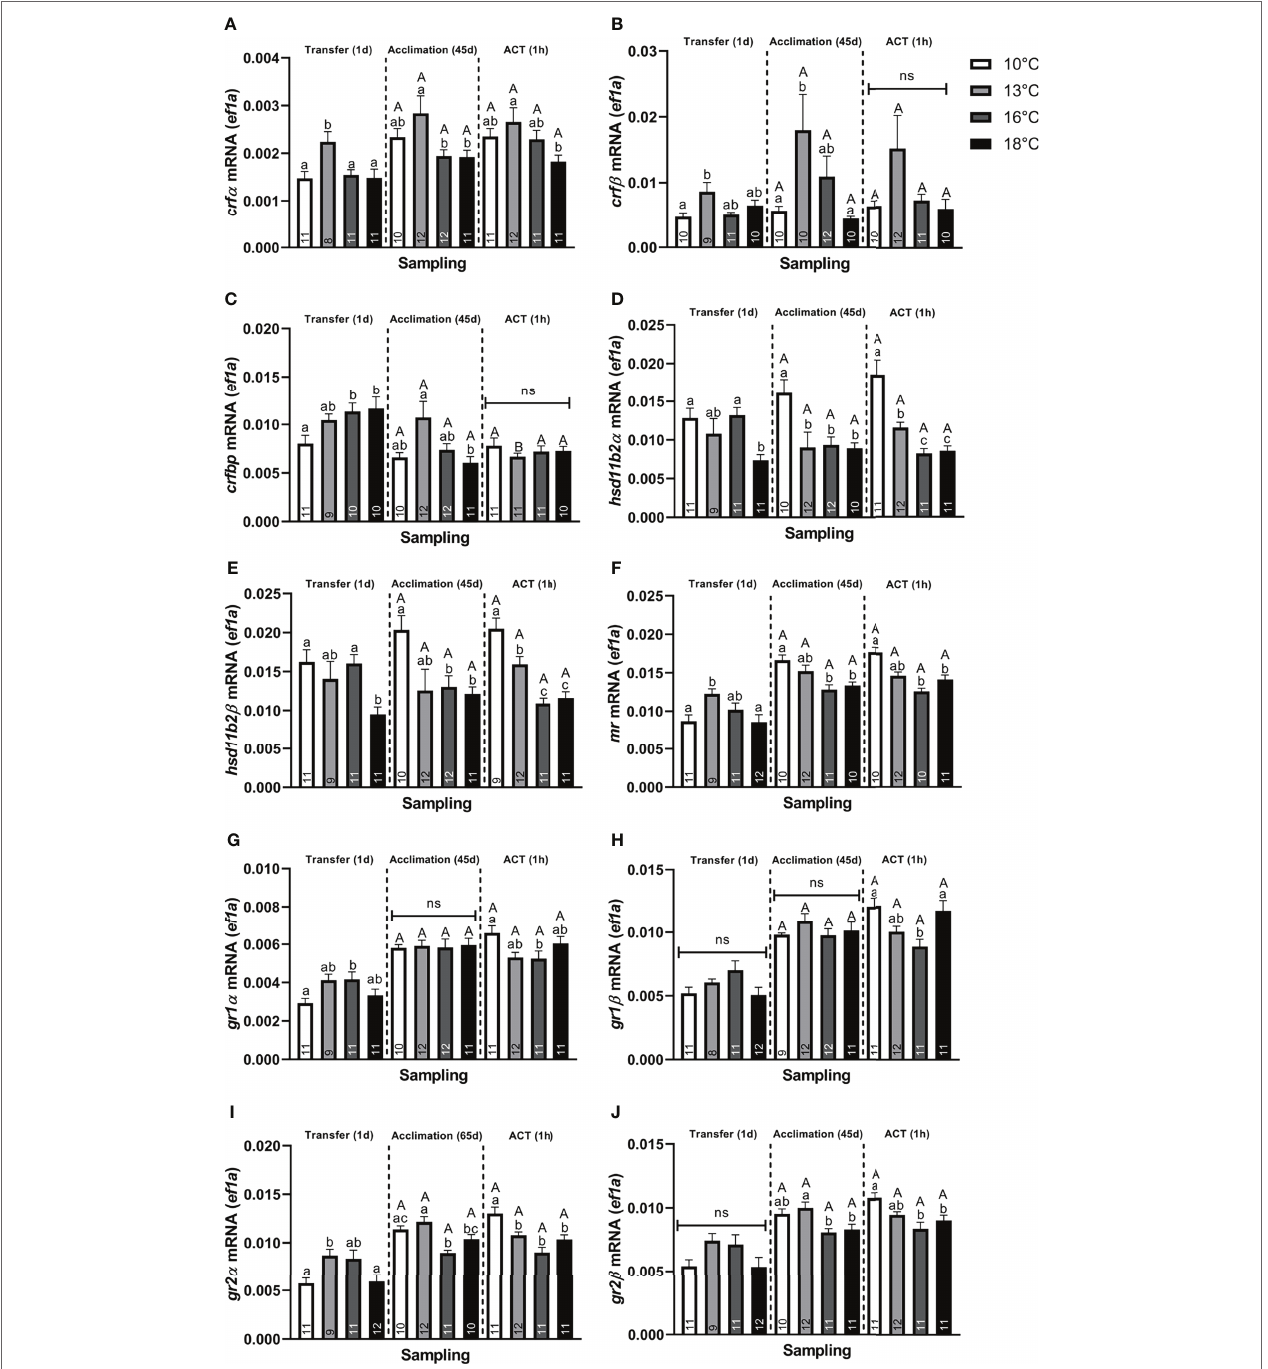
FIGURE 2 | Changes in whole telencephalic expression of (A) corticotropin releasing factor α ( crf α ), (B) corticotropin releasing factor β ( crf β ), (C) corticotropin releasing factor binding protein ( crfbp ), (D) hydroxysteroid 11– β dehydrogenase 2 α ( hsd11b2 α ), (E) hydroxysteroid 11– β dehydrogenase 2 β ( hsd11b2 β ), (F) mineralocorticoid receptor ( mr ), (G) glucocorticoid receptor 1 α ( gr1 α ), (H) glucocorticoid receptor 1 β ( gr1 β ), (I) glucocorticoid receptor 2 α ( gr2 α ), and (J) glucocorticoid receptor 2 β ( gr2 β ) in post–smolts at Transfer (1d), Acclimation (45d), and the ACT (1h). Values are presented as averages ± SEM of each treatment, with sample (n) indicated within each treatment bar of the figure. Uppercase letters indicate significant difference within a treatment between the Acclimation (45d) (non–stressed) and ACT (1h) (stressed), whereas lowercase letters signal a significant difference between temperature treatments within a sampling. A significant difference was held at P <